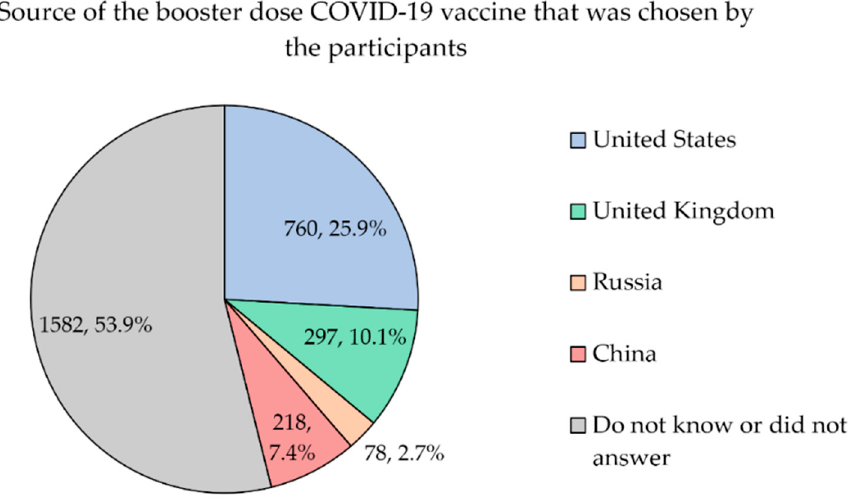
Figure 3. Preferred source of the COVID-19 booster dose chosen by the participants ( n = 2935).